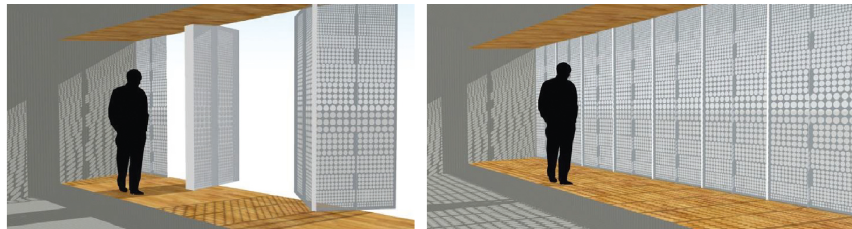
Figure 14: A combined middle axis rotating shaft and horizontal push-and-pull rail to realize multiple interface forms (source: authors’ own